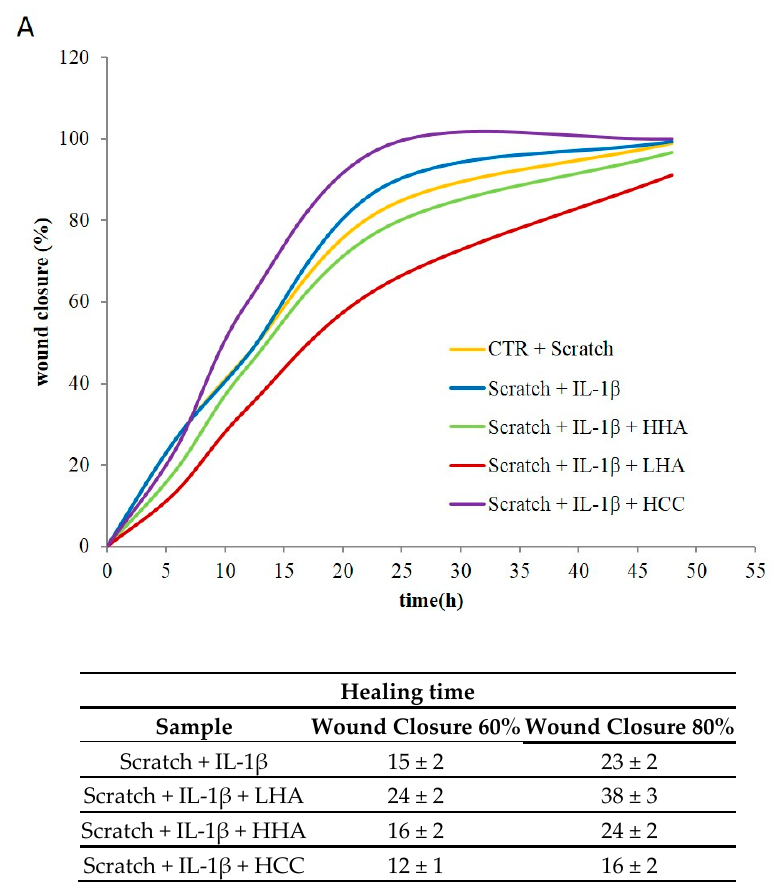
Figure 6. Effects of HHA, LHA, and HCC on HaCaT/HDF scratch test co-cultures. ( A ) Repair area percentage for the control and in the presence of treatments. The repair area percentage is given as (( A 0 – A t )/ A 0 ) × 100, where A 0 and A t are the wound areas just after scratching and after a time t of healing, respectively. The addition of IL-1 β had no effect on wound repair. ( B ) The healing time for each treatment to achieve 60% and 80% wound closure.